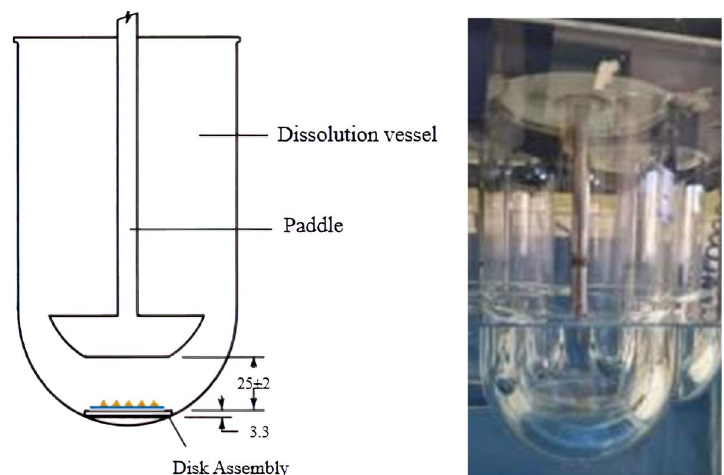
Fig. 3 Paddle over disk for dissolution test